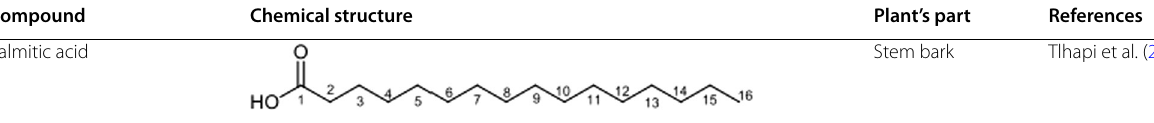
Table 4 Pharmacological activities of B. salicina